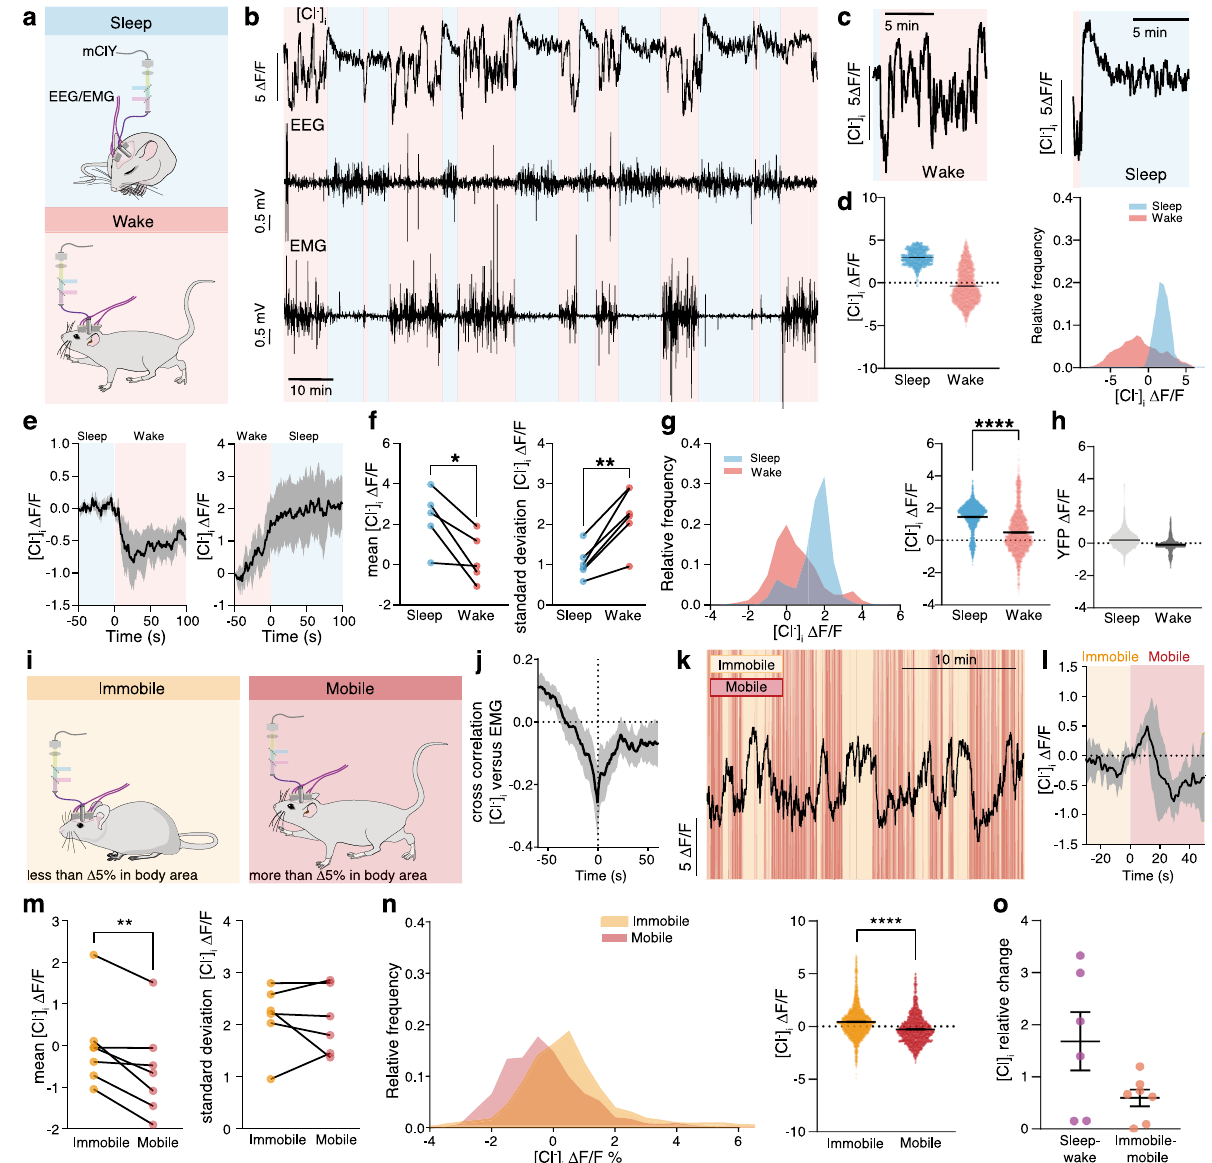
Fig. 1 | Astrocytic [Cl − ] i is lower during wakefulness and fl uctuates during in cortical astrocytes was imaged in awake and resting (immobile) or voluntary locomotion. a [Cl − ] i in cortical astrocytes was imaged using mClY and fi bre running (mobile, 10s immobility followed by more than 1s mobility) mice. j Cross correlation of [Cl − ] i versus SD of EMG. Data represent mean±SEM. N =6 photometryincombinationwithEEG/EMGrecordingsinawake,freelymoving,or spontaneously sleeping mice. b Representative traces of astrocytic [Cl − ] i , EEG, mice, the average Pearson correlation coef fi cient: 0.258. k Representative traces and EMG; colour code indicates sleep and awake periods. c Changes in [Cl − ] i of astrocytic [Cl − ] i , EEG, and EMG; colour code indicates mobile and immobile during transiting from sleep to awake or from awake to sleep in expanded time periods. l [Cl − ] i trace during transition from immobile to mobile state, shading scale. d Distribution of astrocytic [Cl − ] i during sleep and wakefulness. N =1 indicates±SD. N =7mice. m Mean[Cl − ] i ( N =7mice)andstandarddeviation( N =6 representative mouse. e Average [Cl − ] i traces during transition from sleep to mice)during immobileandmobileperiods.Paired two-tailed t -test, ** p =0.0096, p =0.7490. n Distribution of[Cl − ] awake or awake to sleep, shading indicates ±SEM (standard error of the mean). i recorded from awakefreelymoving, mobile or N =6 mice. f Mean [Cl − ] immobile mice. N =6 mice, one sample t -test, **** p <0.001. o Relative changes of i and standard deviation (SD) during sleep and wakeful- [Cl − ] i when transitioning between sleep and awake ( N =6 mice) versus immobile ness. N =6 mice, paired two-tailed t -test * p =0.0296, ** p =0.002. g Distribution and mobile ( N =7 mice). Paired two-tailed t -test. [Cl − ] i =mClY − Δ F/F (%). Data of [Cl − ] i in awake and sleep states recorded from freely moving and naturally sleeping mice. N =6 mice, paired two-tailed t -test, **** p <0.001. h Distribution of represent mean±SEM. Source data are provided as a Source Data fi YFP recorded from freely moving and naturally sleeping mice. N =3 mice. i [Cl − ] i